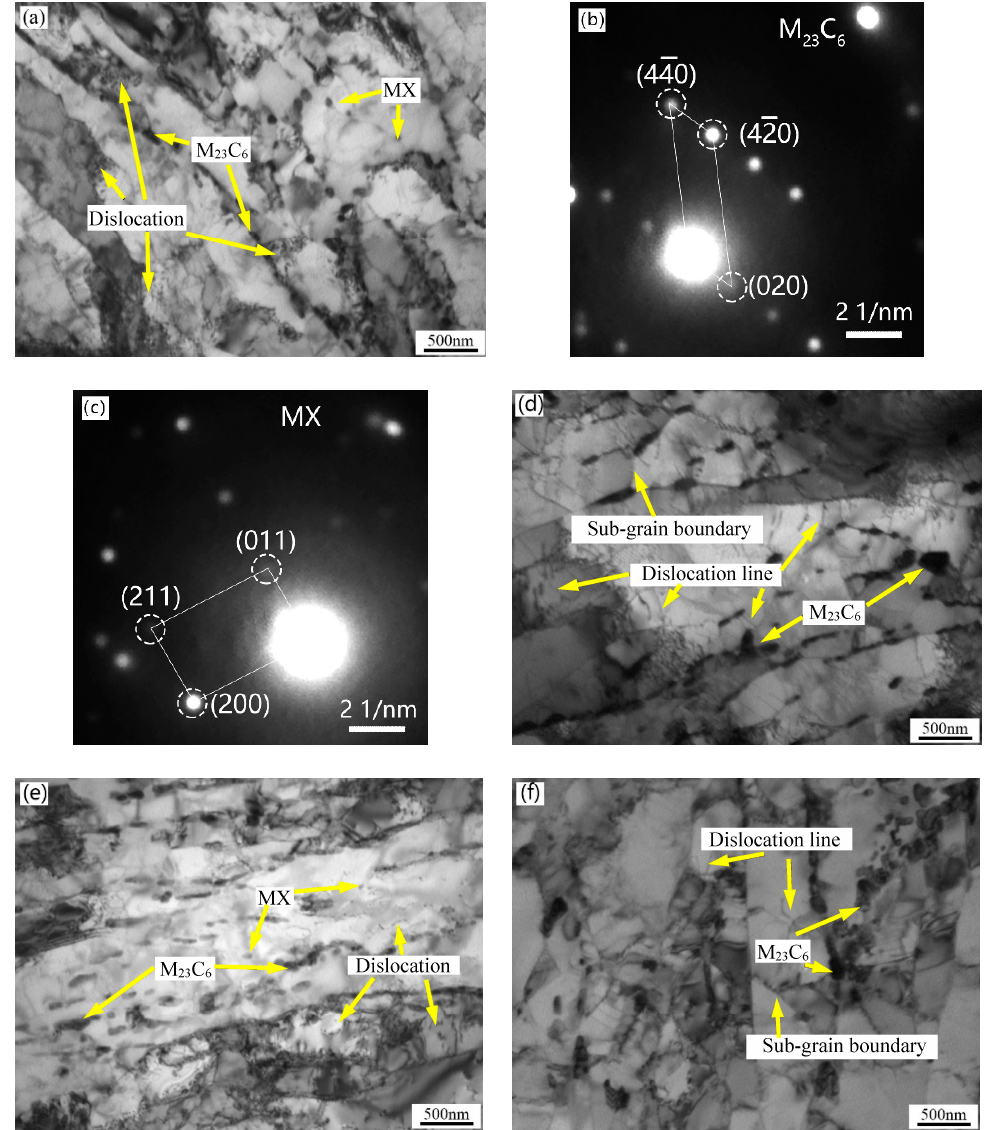
Figure 6. TEM images of the experimental steels after heat treatment ( a ) 1L (low Si and low temperature), ( b , c ) selected area electron diffraction (SAED) pattern of M 23 C 6 and MX in 1L, ( d ) 1H (low Si and high temperature), ( e ) 2L (high Si and low temperature), and ( f ) 2H (high Si and high temperature).